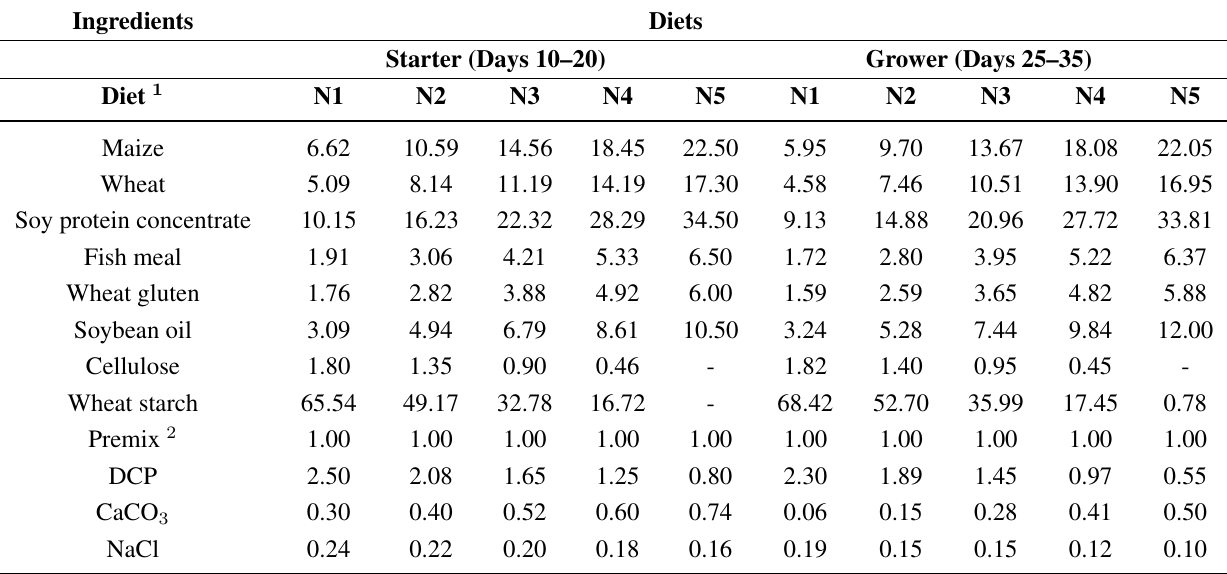
Table 1. Composition of experimental diets (percentage as fed).